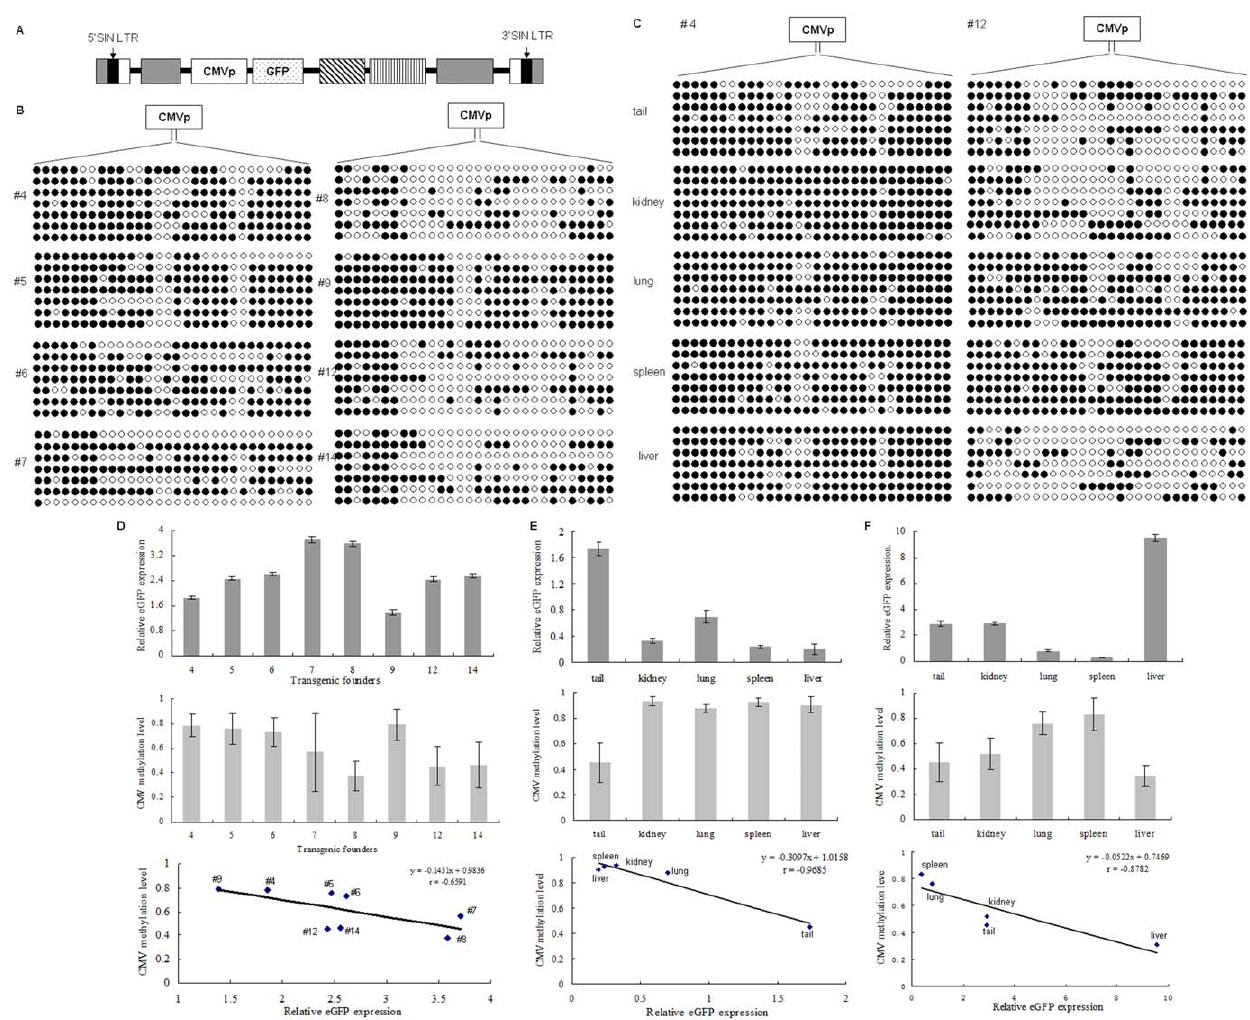
Figure 5. Correlation of CMV promoter methylation status with GFP expression level of transgenic sheep. (A) Schematic of pLEX-EGFP vector. (B) Status of the CMV promoter methylation in 8 transgenic sheep. The 487bp sequences of CMV promoter containing one CpG islands were targeted for methylation analysis. Genomic DNAs extracted from 8 transgenic lambs ( # 4–12) were treated with bisulfite and sequenced at least 7 clones for each sample. (C) Status of the CMV promoter methylation in tested tissues of two anatomized lambs ( # 4 and # 12). Genomic DNAs extracted from tail tips, liver, lung, kidney and spleen were treated with bisulfite and sequenced at least 7 clones for each sample. The black cycles represented the methylated CpG and the white cycles represented the non-methylated CpG. ( D) Correlation of GFP expression with methylation level of lentiviral CMV promoter of transgenic lambs. Densitometric quantification of the relative GFP expression was assayed by Western blotting (Fig. 3B) in tail tips of transgenic lambs # 4–14 (up panel). Methylation levels were measured by the average ratios of methylated CpGs to total CpGs of the target CMV promoter sequence (middle panel). Correlation of the methylation levels of CMV promoter with GFP expression of 8 transgenic sheep was analyzed (low panel). (E and F) Correlation of GFP expression with methylation levels of CMV promoter in tested tissues of anatomized lambs ( # 4 and # 12). Densitometric quantification of the relative GFP expression was assayed by Western blotting (Fig. 4B) in tissues of # 4 (E, up panel) and # 12 (F, up panel) lamb. Methylation levels of CMV promoter in tested tissues of # 4 (E, middle panel) and # 12 (F, middle panel ) lambs were based on Fig. 5C. The average rate of methylated CpGs in the 487 bp region of CMV promoter was defined as the indicator of methylation status. Correlation of methylation levels of CMV promoter with GFP expression levels was analyzed in tested tissues of # 4 (E, low panel) and # 12 (F, low panel)